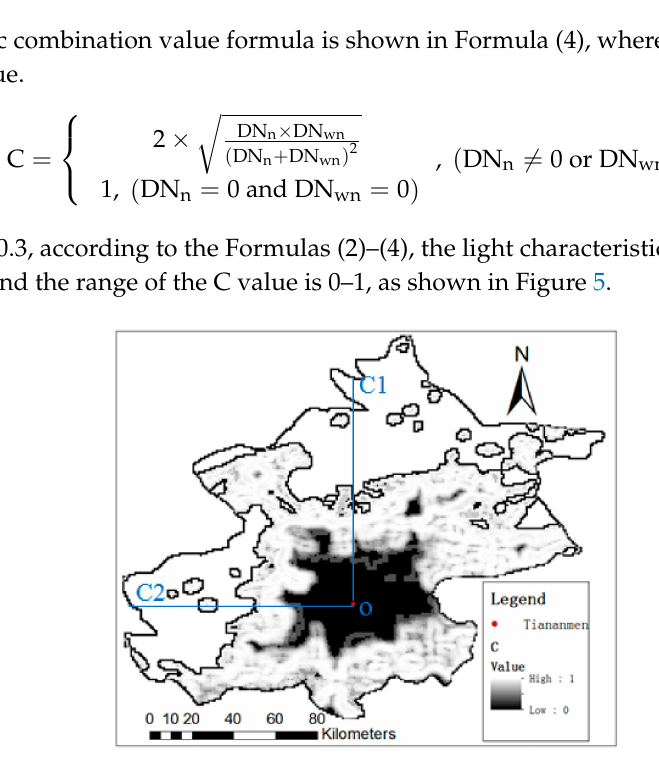
Figure 5. Light characteristic combination value.